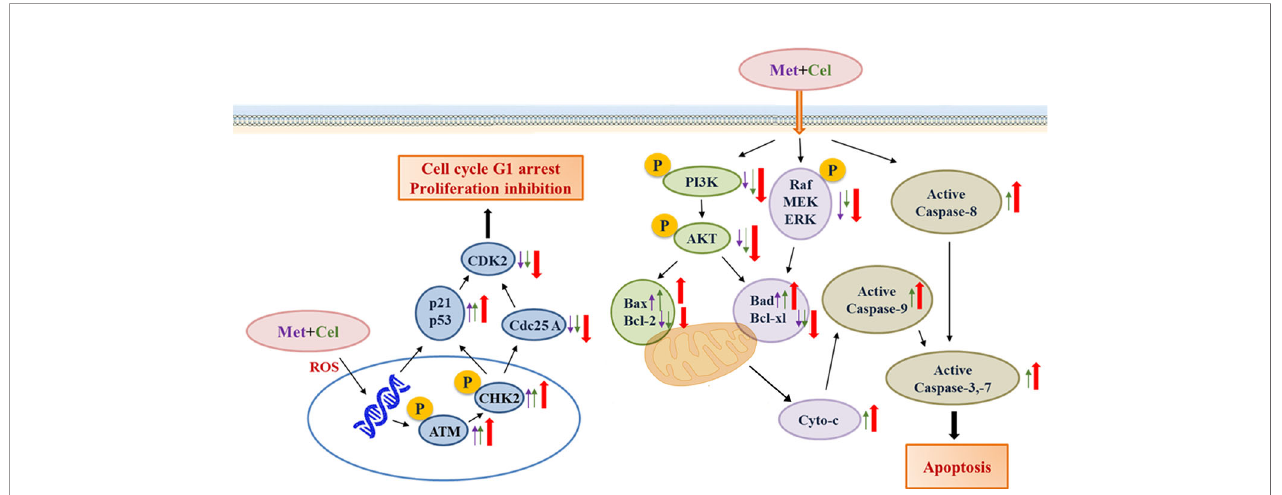
FIGURE 9 | A working model for the synergistic effects of celecoxib and metformin on NSCLC cells. The purple arrow represents protein expression changes in response to metformin, the green arrow represents protein expression changes in response to celecoxib, and the red arrow represents protein expression changes in response to combination treatment with celecoxib and